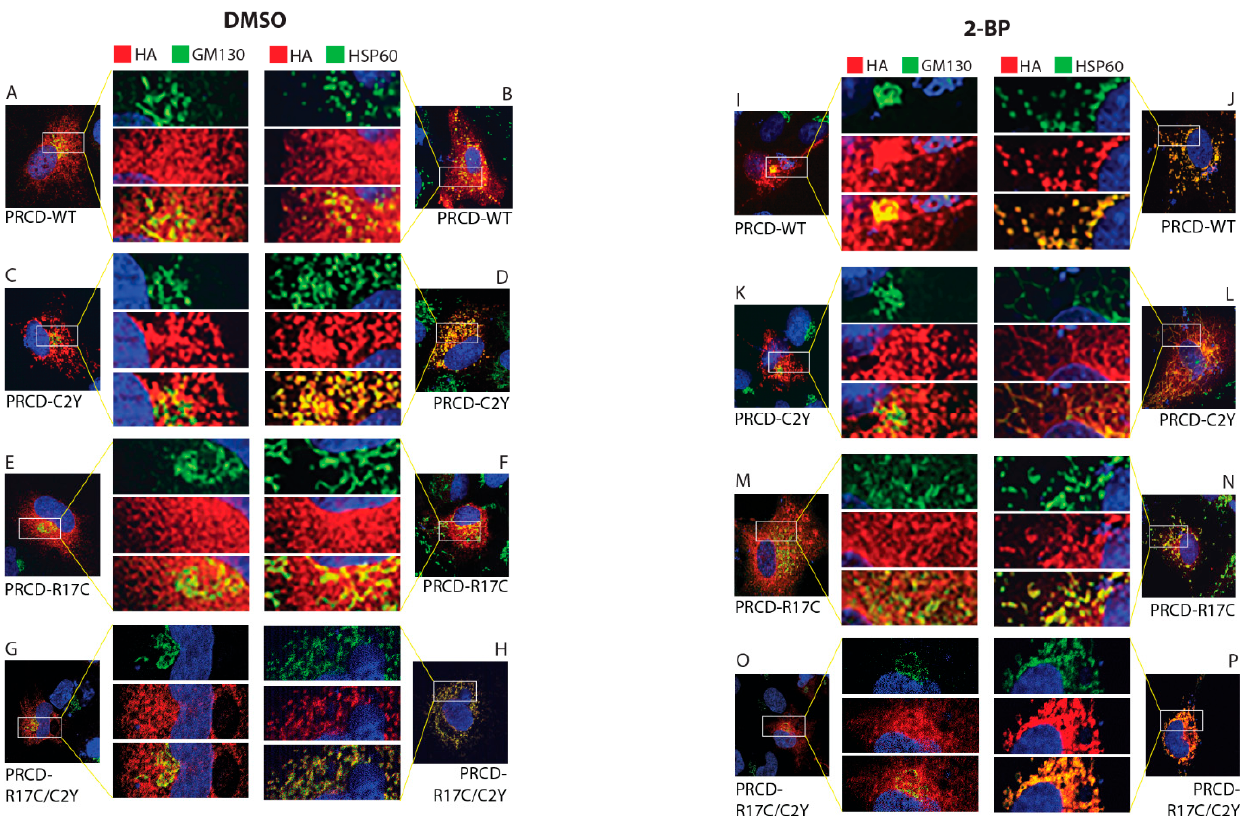
Figure 4. Palmitoylation of cysteine in the second amino acid position is essential for proper localization. Immunocytochemistry of transiently transfected hRPE1 cells with PRCD-WT, and PRCD-R17C display similar localization ( A , E ; B , F ). Endogenous palmitoylation lacking PRCD-C2Y, and double mutant PRCD-R17C/C2Y showing aggregation mislocalization in the subcellular compartment likely localized with HSP60, a mitochondrial marker ( C , G ; D , H ). PRCD’s (HA, red) localization in regards to the Golgi complex (GM130, green) and Mitochondria (HSP60, green). Nuclei are stained blue with DAPI. A-H, hRPE1cells treated with control vehicle, DMSO. ( I – P ) hRPE1 cells treated with 150 μ M 2-BP, a palmitoyl inhibitor, for 24 h post-transfection show mislocalization with HSP60. The middle panel show enlarged images.